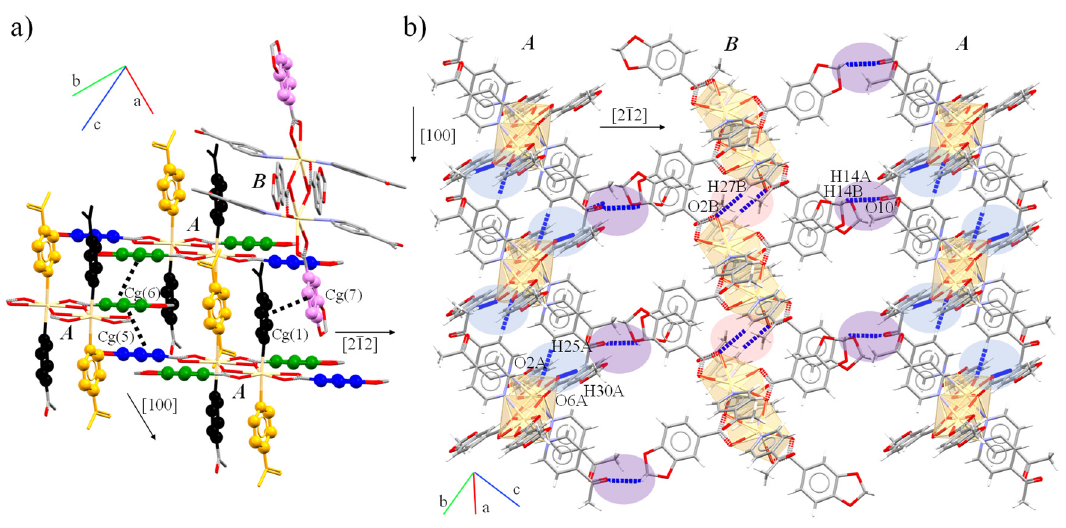
Figure 6. Intermolecular ( a ) π · · · π and ( b ) C-H · · · O interactions between A and B dimers present in 3 . Color codes: Cg(1) black; Cg(2) orange, Cg(5) dark blue; Cg(6) dark green; Cg(7)